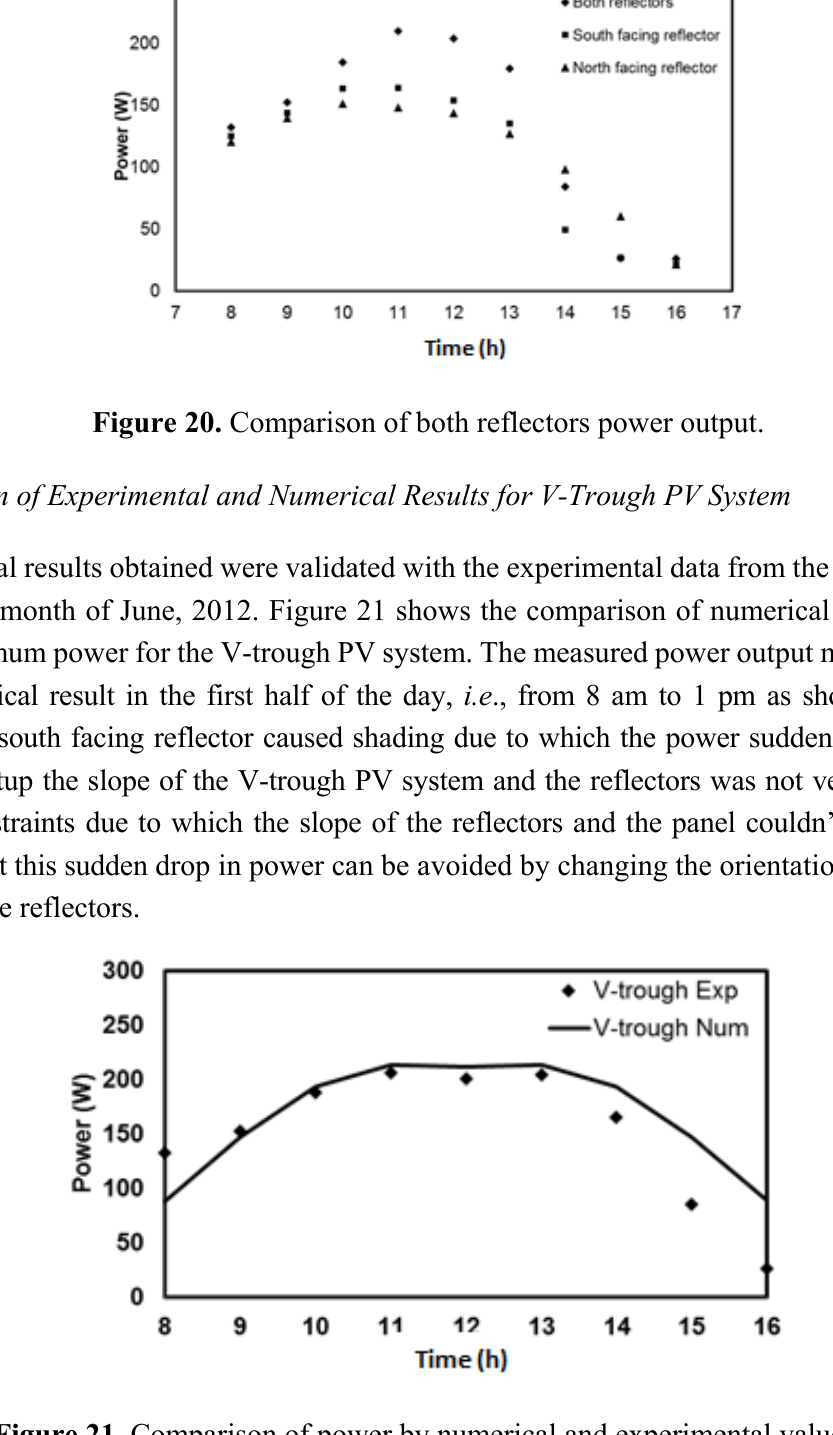
Figure 21. Comparison of power by numerical and experimental